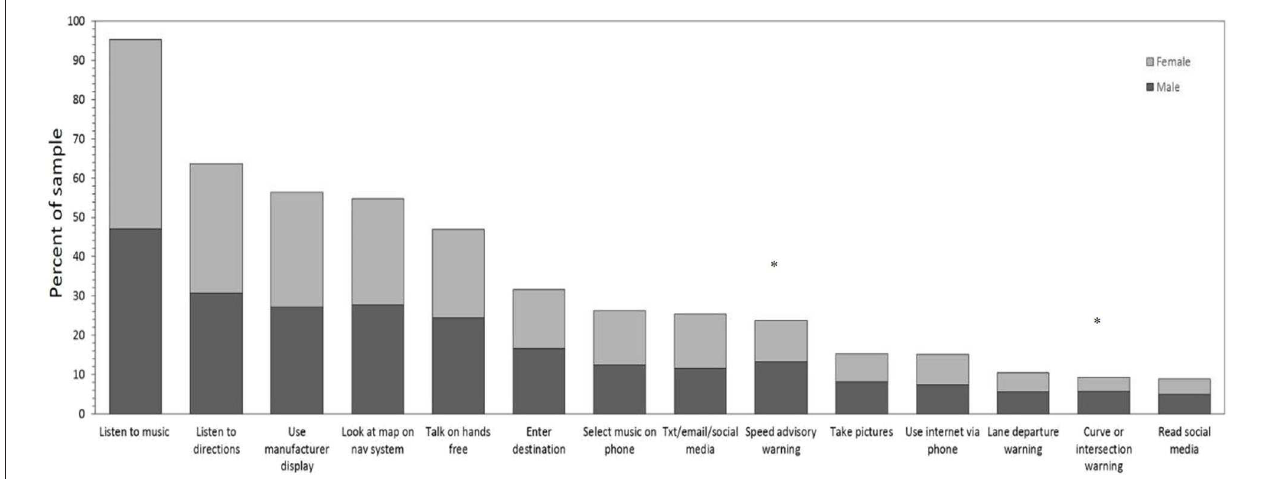
FIGURE 1 | The percentage of male and female drivers reporting engaging in each activity or experiencing each event while driving (*indicates significant difference) ( p < 0.05) between males and females.